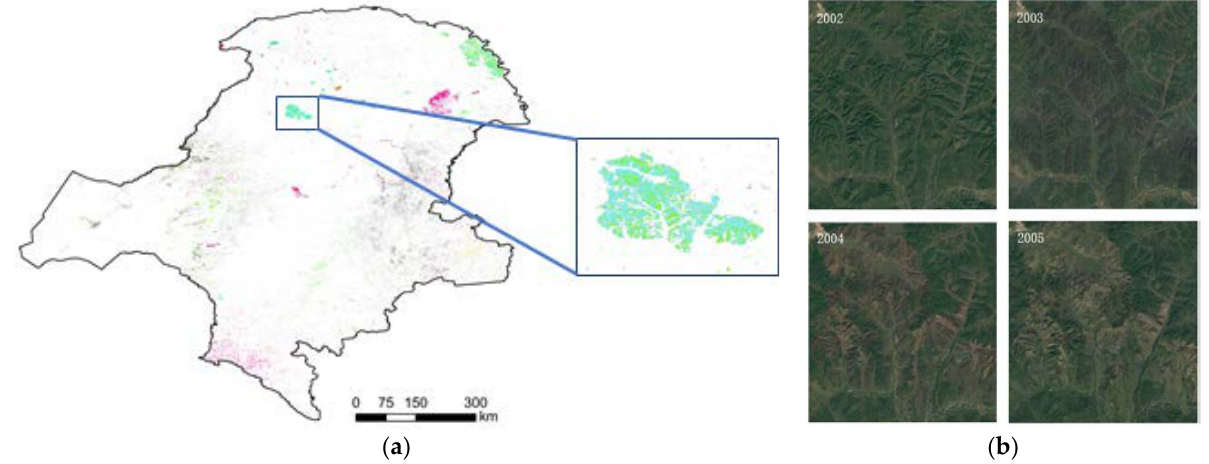
Figure 12. ( a ) Typical disturbance area and ( b ) remote sensing images, in Great Khingan Mountain (GKM),